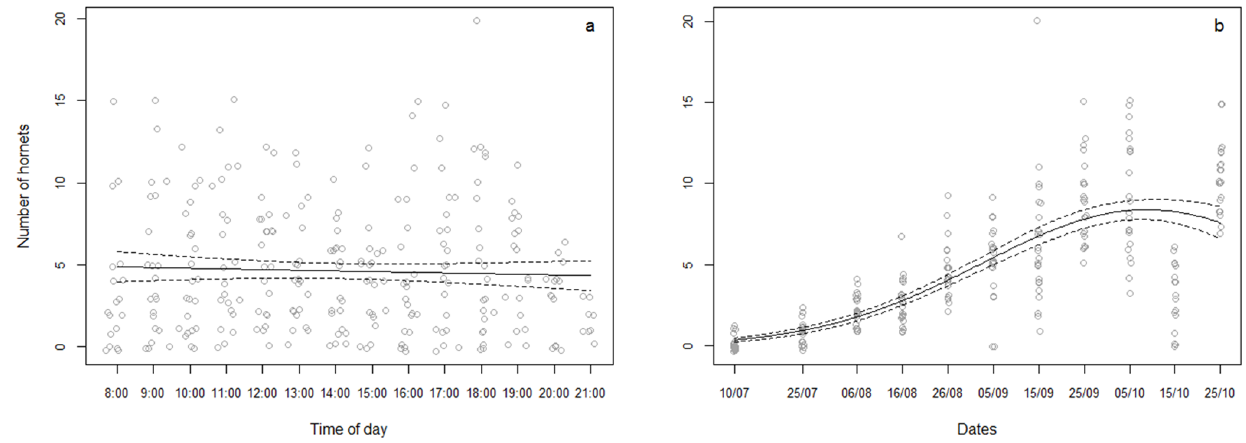
Figure 4. Variation of the number of Vespavelutina during a) the day and b) the season. The data are pooled for H1 and H2. Predicted values fitted with the GLM model (plain line) with 95% confidence interval (dash